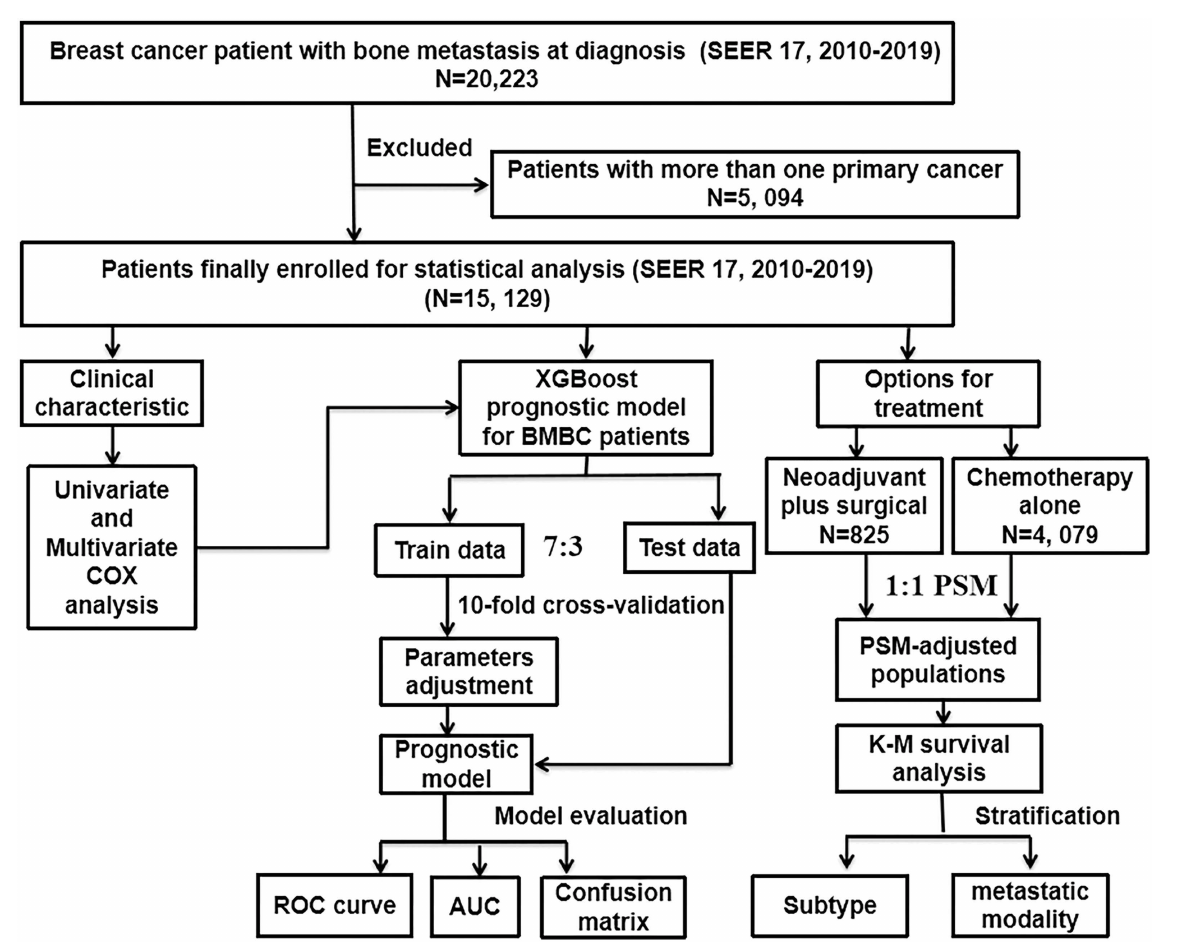
FIGURE1 The flowchart described the process of conducting the study and statistical analysis. SEER, the Surveillance, Epidemiology, and End Results database; BMBC, bone metastatic breast cancer; PSM, propensity score matching; COX, concordance index; ROC curve, receiver operating characteristic curve; AUC, area under the curve; K–M, Kaplan–Meier; XGBoost, extreme gradient